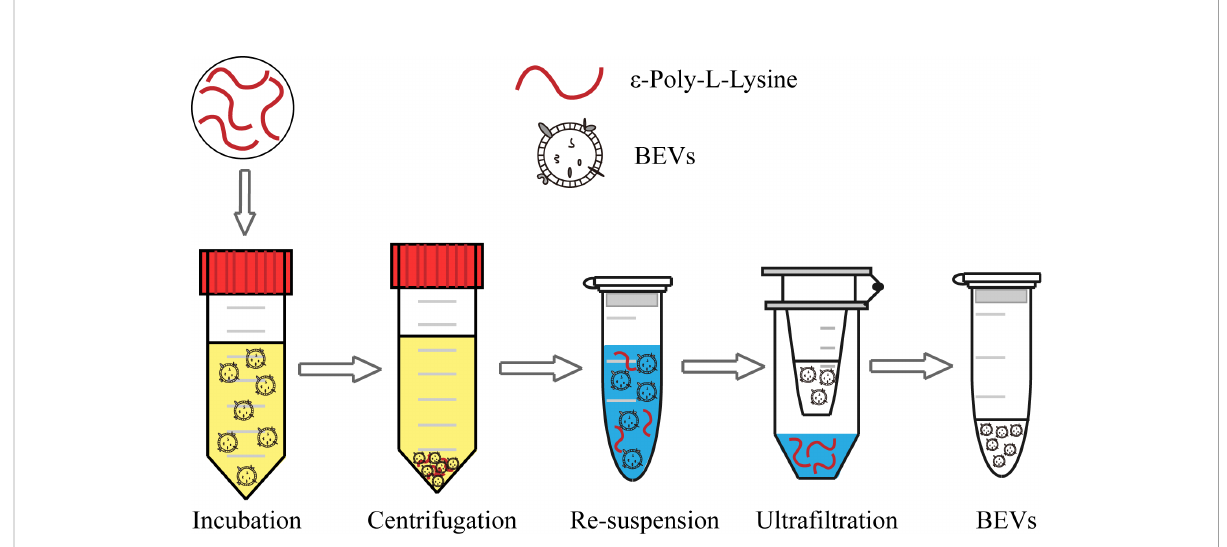
FIGURE 1 Schematic of the BEV isolation from the bacterial culture medium using the ϵ -PL-based